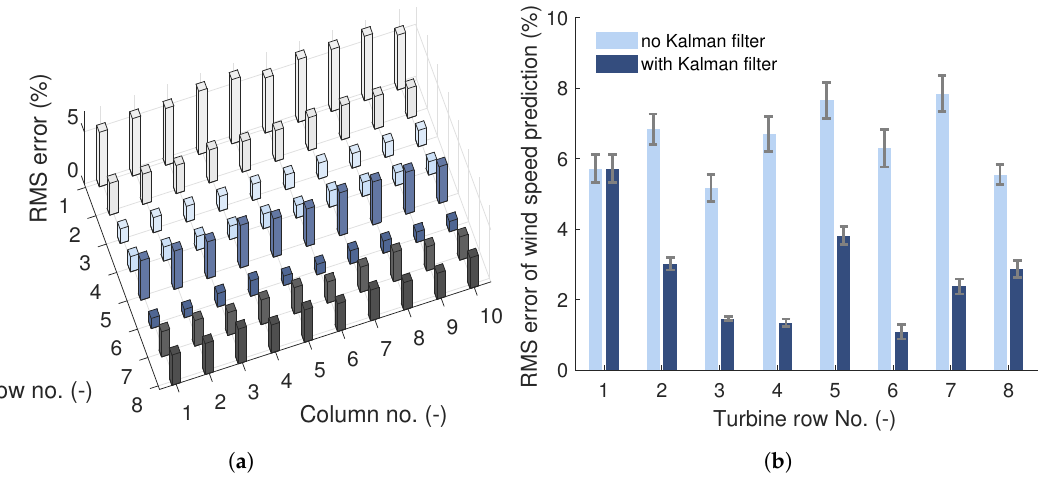
Figure 10. Accuracy of DFP in estimation of current rotor effective wind speed at turbines of large-scale wind farm. Accuracy is quantified as normalized RMS error of wind speed estimated using DFP given SWF as reference. Shown are ( a ) distribution of accuracy across turbines in wind farm with DFP using Kalman filter, and ( b ) effect of Kalman filter on row-wise accuracy statistics, that is, mean error (bars) and standard deviation of error (errorbars).